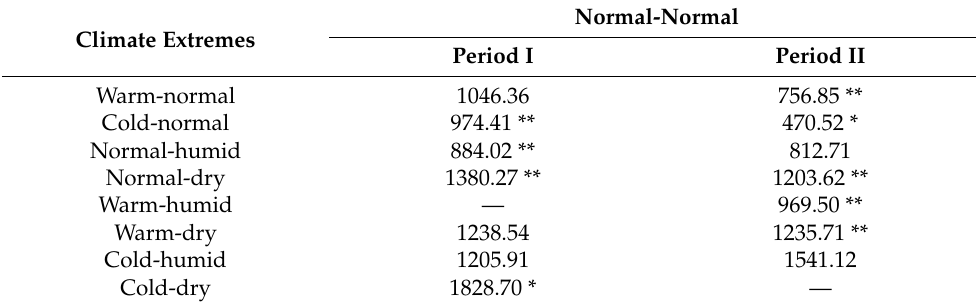
Table 3. MSE values of yield changes between climatic extremes and normal climate during periods I and